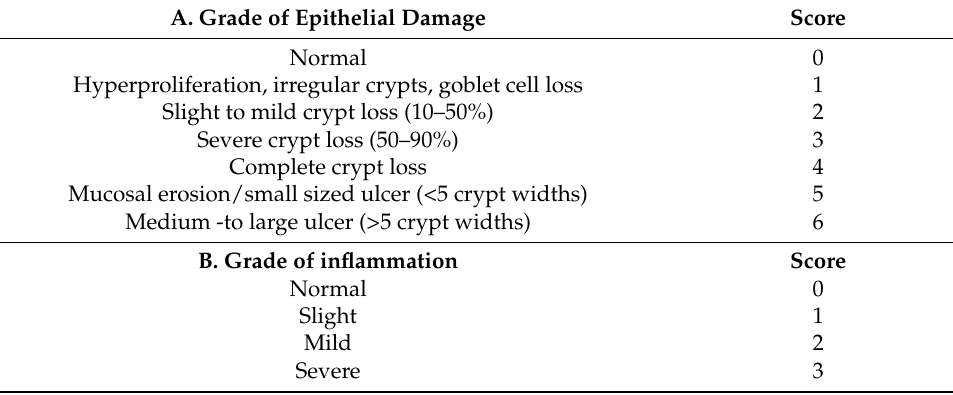
Table 1. Histological score of